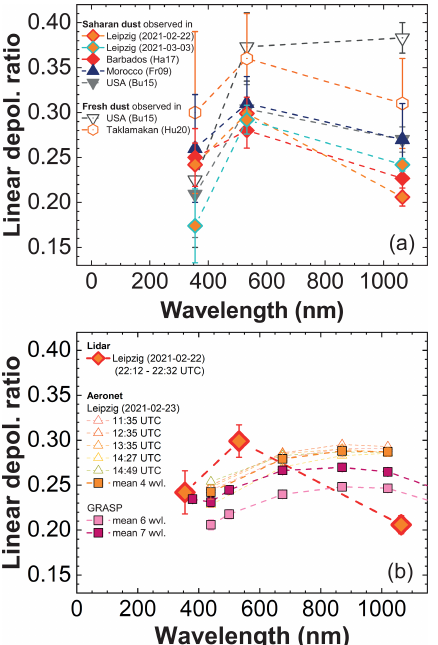
Figure 4. (a) Spectral dependence of the lidar ratio of Saharan dust observed at Leipzig and Barbados (during SALTRACE). The lidar ratio at 1064nm during SALTRACE (open diamond) was estimated on 20 June 2014 combining AERONET AOD and lidar observa- tions (see text for explanations and Mamouri and Ansmann, 2017; please note that the date format is year-month-day). (b) Spectral de- pendence of the lidar ratio of Saharan dust observed in the night of 22–23 February 2021 compared with AERONET v3 inversion solutions for the lidar ratio on 23 February 2021. The results of the five photometer scans (open triangles) at indicated times are shown together with the mean of the four-wavelength retrieval (or- ange squares, standard retrieval) and the six- and seven-wavelength retrieval (pink and purple squares, GRASP method). The GRASP retrieval at 1640nm (not shown) leads to lidar ratios of 94 ± 8 (us- ing six wavelengths) and 101 ± 4sr (using seven wavelengths).